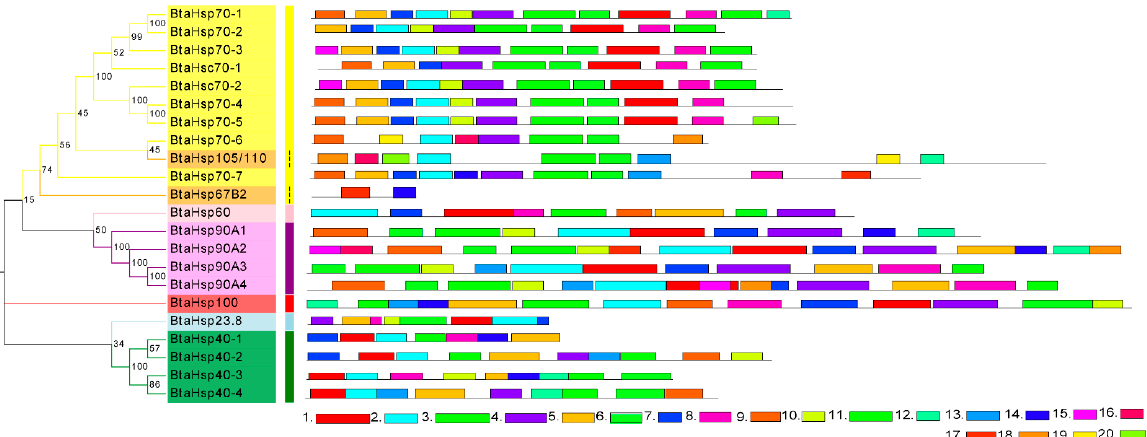
Figure 6. Phylogenetic relationships and protein motif analysis of the Bemisia tabaci heat shock pro ‐ (BtaHSP) gene superfamily. The unrooted phylogenetic tree was constructed using MEGA7 by the neighbor-joining method and the bootstrap test was set as 1000 replicates. The colored shadow repre- sents the different BtaHsp families. The MEME database identified all the motifs with the complete amino acid sequences of BtaHsp s. Lengths of each BtaHSP motif were demonstrated